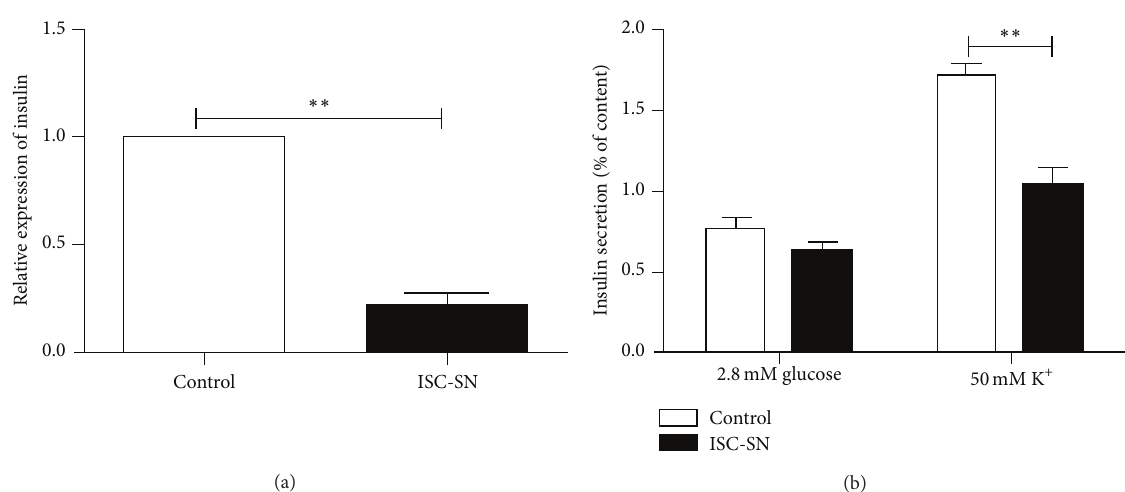
Figure 5: Effects of ISC-SN on insulin mRNA transcript and INS-1 cell function. (a) qRT-PCR analysis of insulin mRNA expression and (b) KSIS assay on INS-1 cells cultured with ISC-SN for 24 h. Insulin mRNA data were normalized by GAPDH gene, and insulin secretion data were normalized by cellular insulin content. Data are expressed as mean ± SE ( 𝑛 = 4 to 5), ∗∗ 𝑃 < 0.01